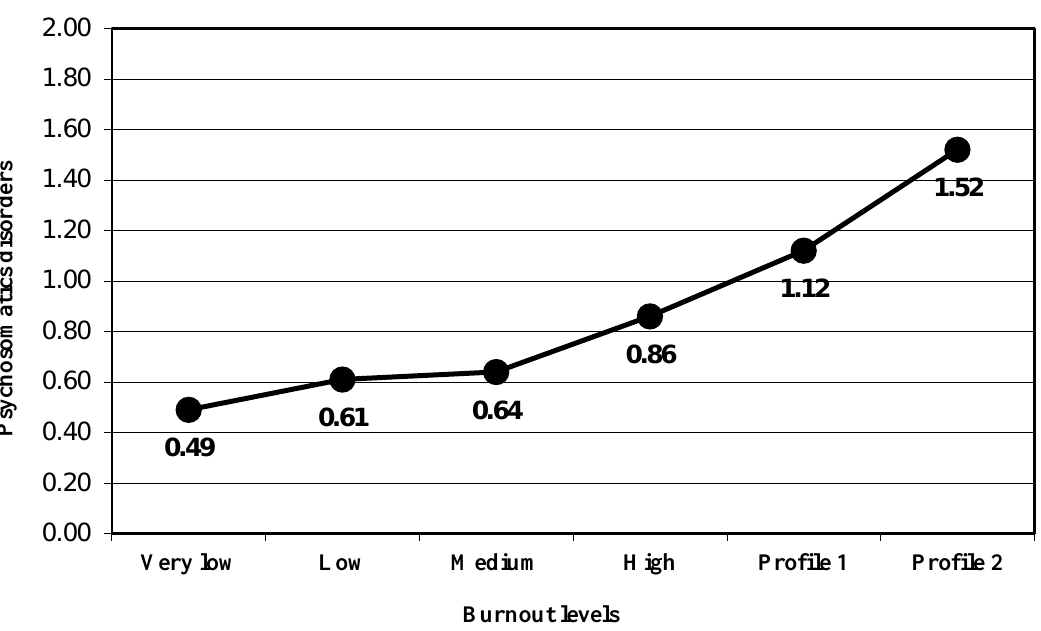
Figure 2. Mean in the psychosomatic disorders variable for the groups of burnout levels.